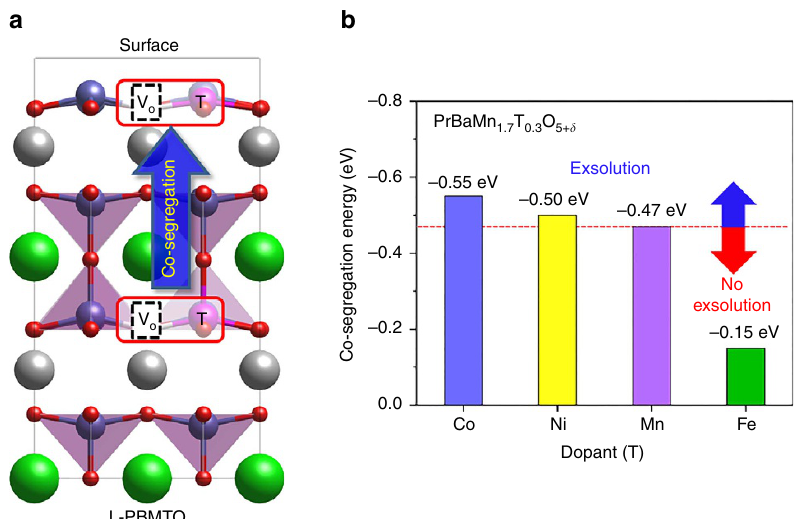
Figure 3 | Density functional theory calculations for elucidating co-segregation energy. ( a ) Schematic illustration of our model used for the calculations of co-segregation energy. Pr, Ba, Mn, T (Mn, Co, Ni and Fe) and O atoms are shown as grey, green, dark blue, purple and red, respectively. The inset red boxes indicate the co-segregation of B-cation with an oxygen vacancy. ( b ) Comparison of the co-segregation energy with the dopant (T) materials.